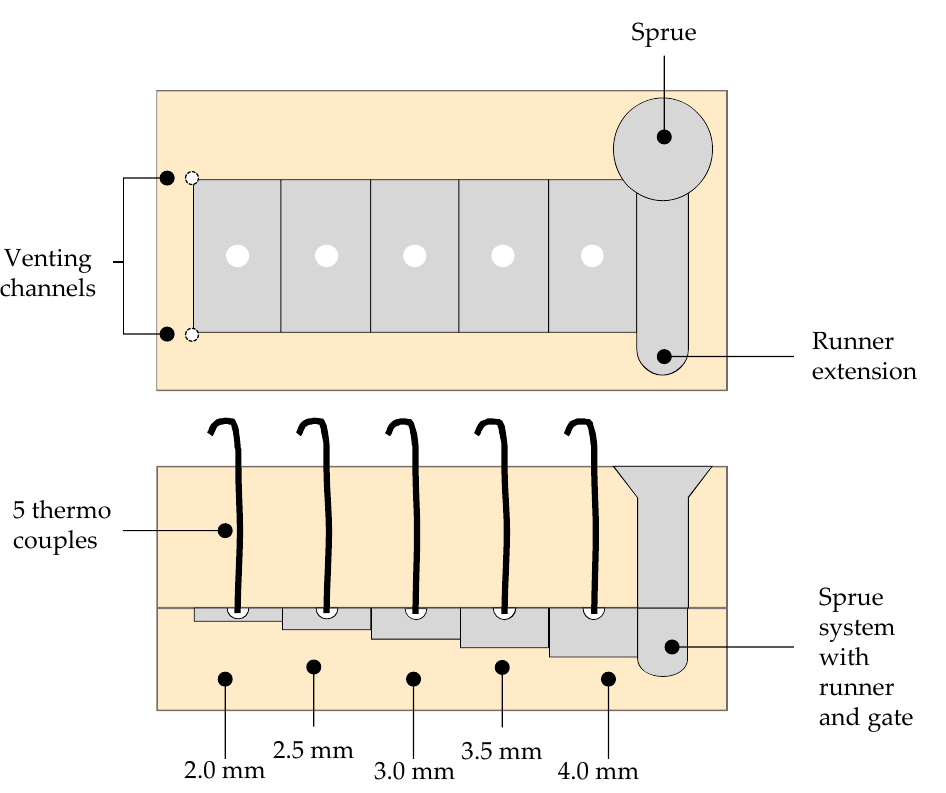
Figure 2. Experimental setup with the measurement of solidification curves.